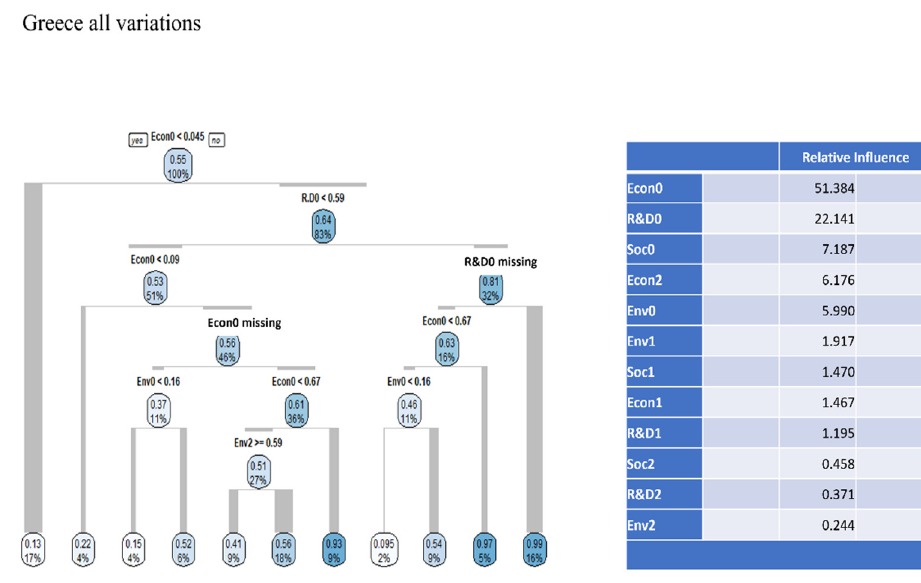
Figure 7. CART trees for Greece under all DEA variations.